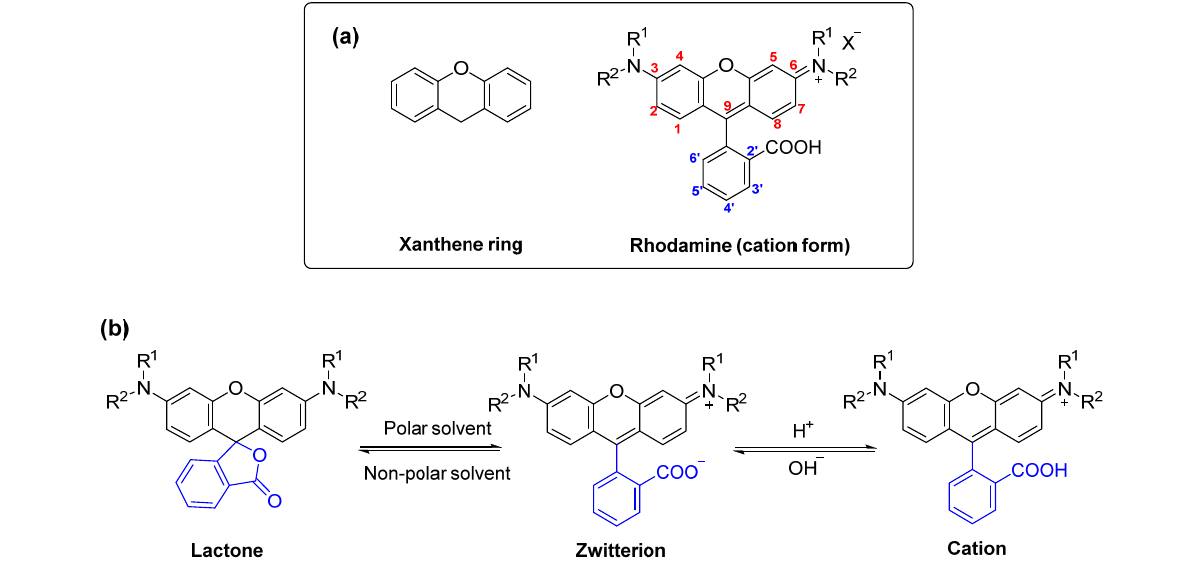
Figure 1. ( a ) General structure of xanthene and rhodamine dyes; ( b ) Molecular structures of three rhodamine forms in equilibrium.